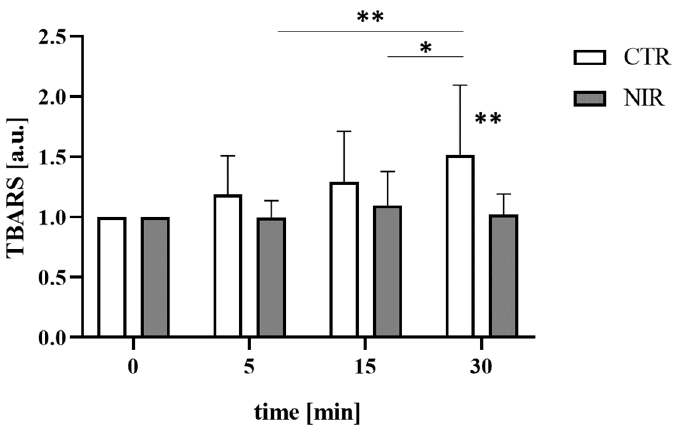
Figure 4. Changes in lipid peroxidation of the RBC membrane during HD in vitro. Results are presented as mean and SD. The number of independent experiments measurements n = 13 for both groups. Pairs of variables that differed statistically were denoted on the chart with the following symbols: * p < 0.05, ** p < 0.01.